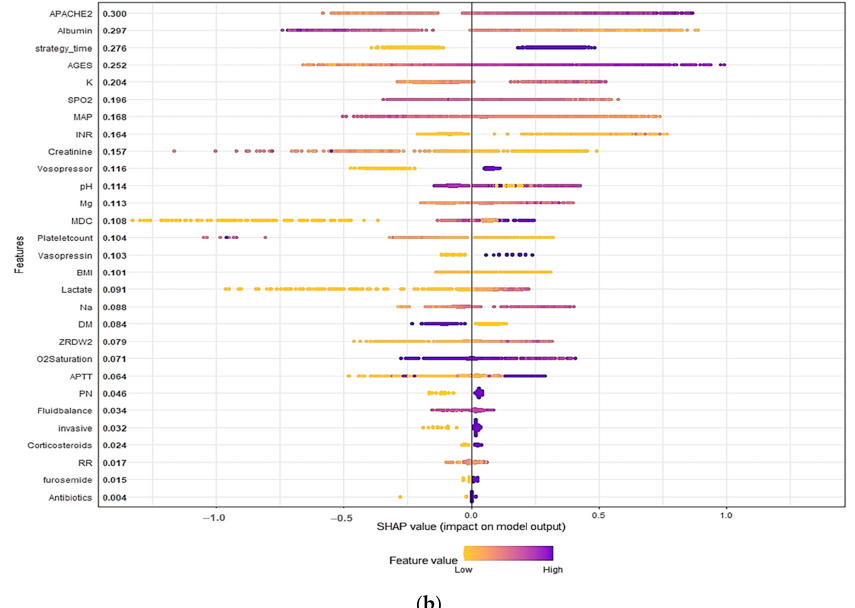
Figure 7. Summary SHapley Additive exPlanations (SHAP) plot. ( a ) Global feature importance in final XGBoost model output. ( b ) Relationship between features and in-hospital mortality in XGBoost model. Diversion on x -axis represents effect on model output, with colors used to represent low (yellow) to high (purple) value of predictors. Figure 8 depicts four local explanation graphs of randomly chosen patients. Our proposed model correctly predicted the risk of in-hospital death for patients A and B but incorrectly predicted the risk for patients C and D.